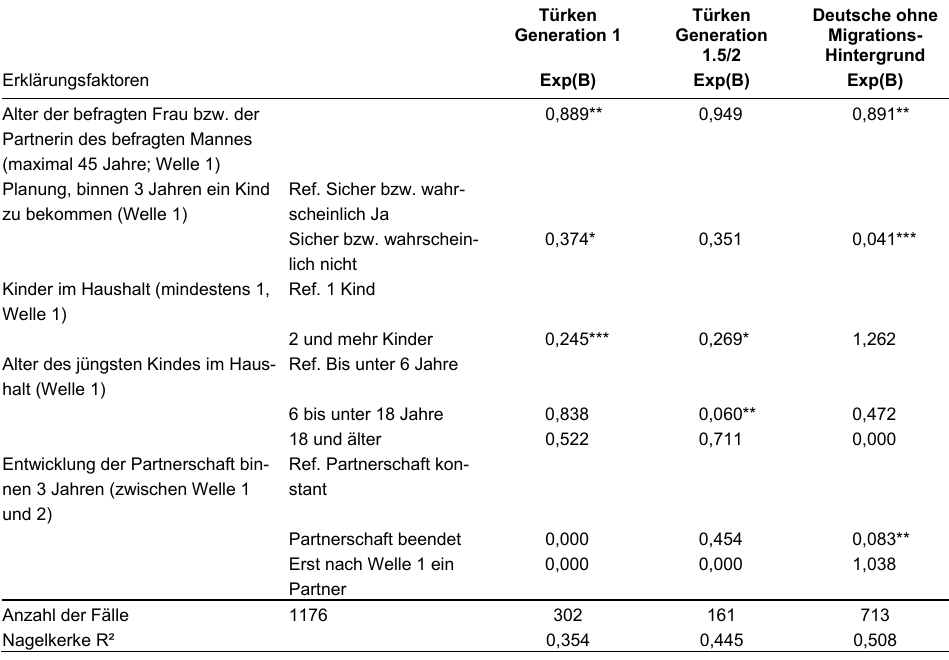
Tabelle 4 : Erklärungsfaktoren für die Familienerweiterung – Modell 3: Situation, Wunsch und